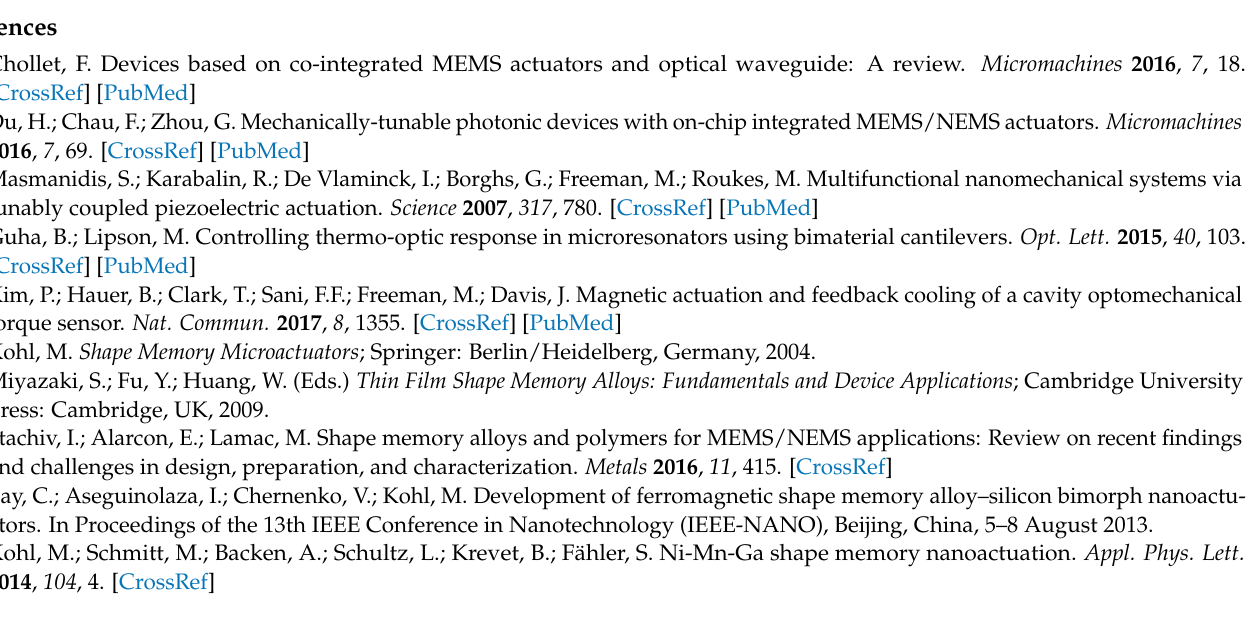
Figure A1. Experimental setup used for in situ SEM measurements of electrical resistance. ( a ) Schematic of the chip layout consisting of many microactuators arranged in an array and electrical interconnections. Each microactuator has two contact pads (A and B) for electrical interconnection, whereby the contact pads A of each microcactuator are electrically connected with each other and with two large pads being interconnected via wire bonding. In addition, two nanomanipulators are used to establish electrical interconnections to the second contact pads B of each single microactuator in a time sequence one after another. ( b ) SEM images taken during in situ electrical measurement showing a single microactuator and the nanomanipulator tips used for electrical